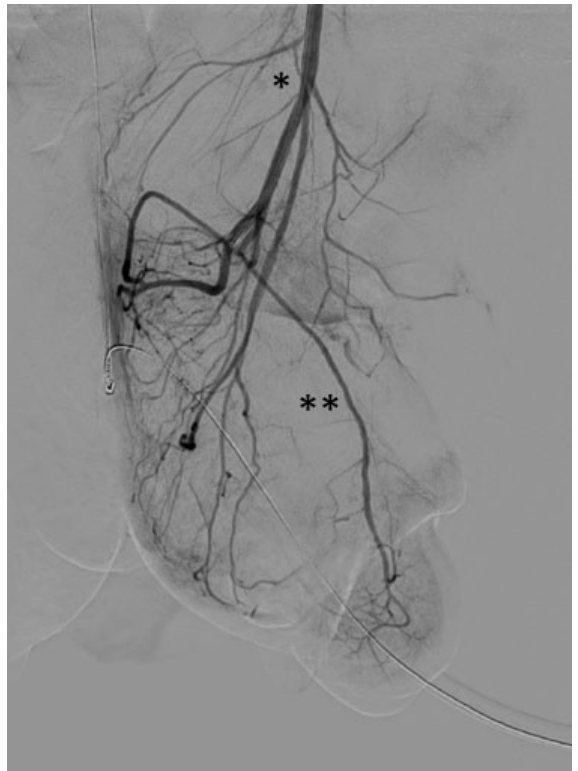
Fig. 2 Digital subtraction angiography (DSA) of theleft internal pudendal artery ( (cid:1) ) via microcatheter (Progreat 2.7F, Terumo) con fi rmed a suf fi cient arterial perfusionof the glans withgoodcontrast fi lling of thedorsal artery of the penis ( (cid:1)(cid:1) ).